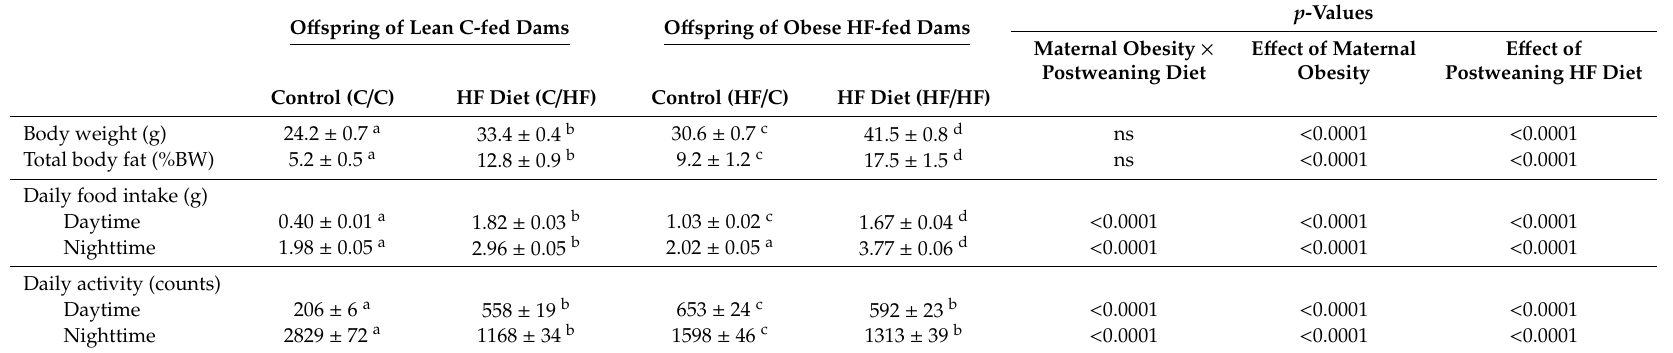
Table 1. Phenotypic and behavioural profiles of the o ff